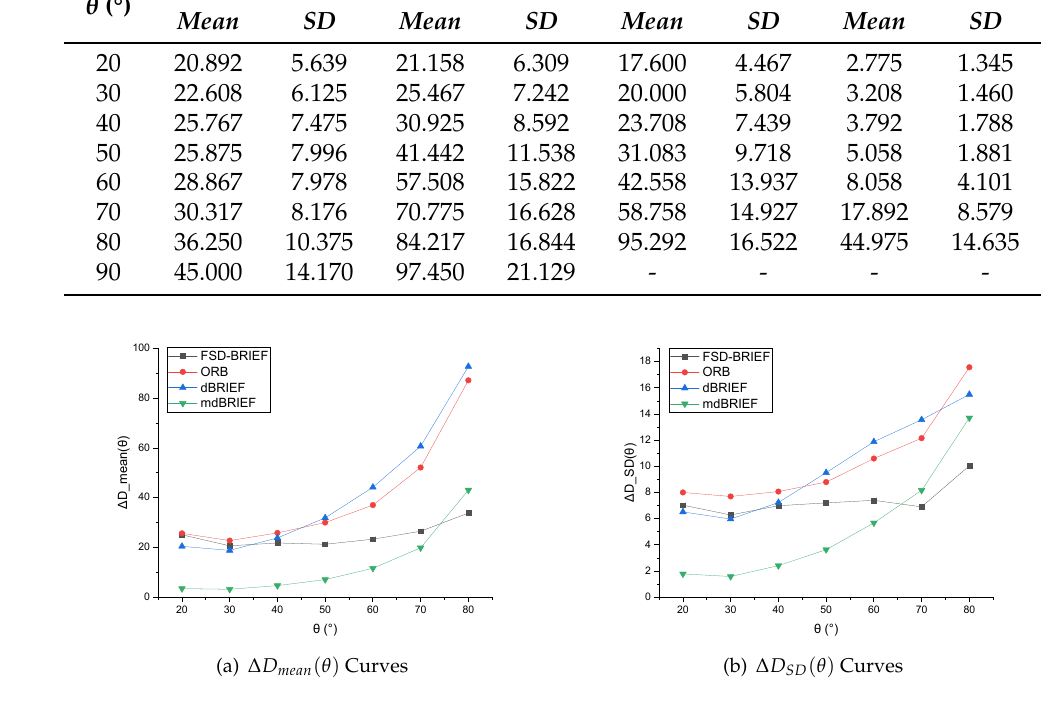
Figure 11. ∆ D − θ curve results in 170° FoV